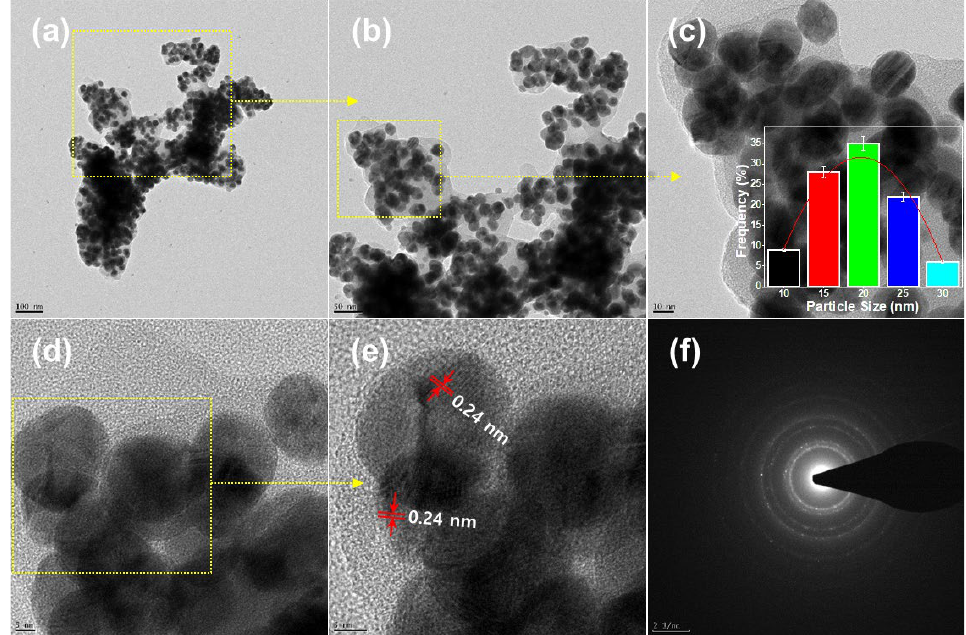
Figure 3. ( a – e ) TEM/HRTEM images and ( f ) the corresponding SAED pattern of the synthesized CDs@AgNPs (inset ( c ) is the particle size distribution graph of the CDs@AgNPs).